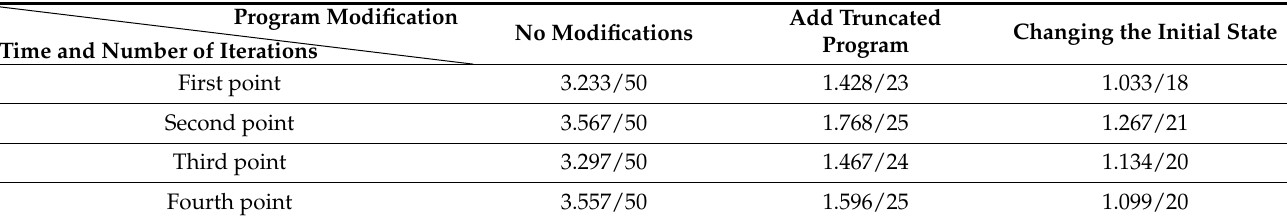
Table 3. The number of iterations and time for the three